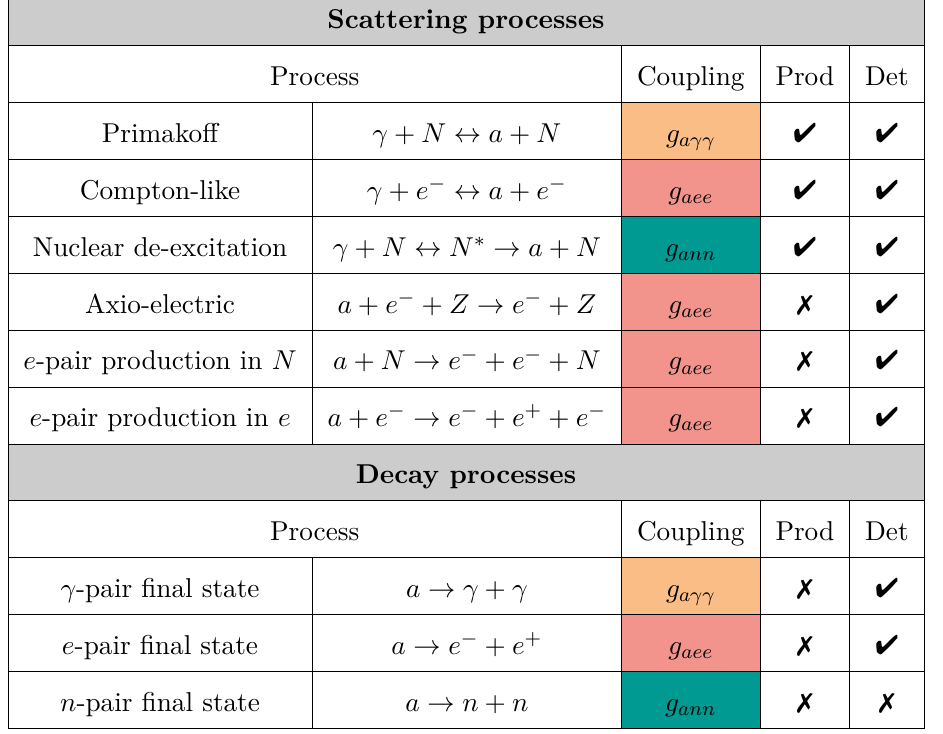
Table 2 . ALPs production and detection mechanisms. Check marks (crosses) are used to identify (exclude) production and/or detection processes. Color refers to processes that should be — in principle — included in a self-contained one-parameter analysis. Note that decay to nucleon pairs is forbidden by kinematic arguments. The color code refers to the different couplings that each process is sensitive